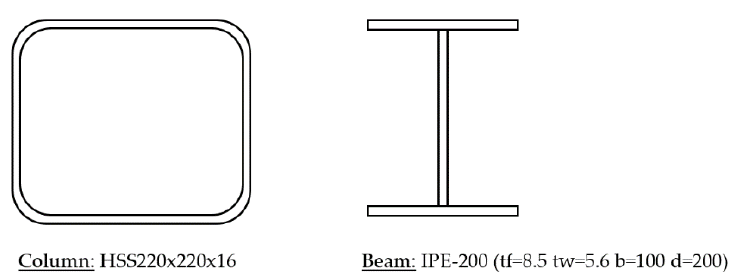
Figure 2. View of End Plate to Hollow Structural Section (EP-HSS) moment connection.